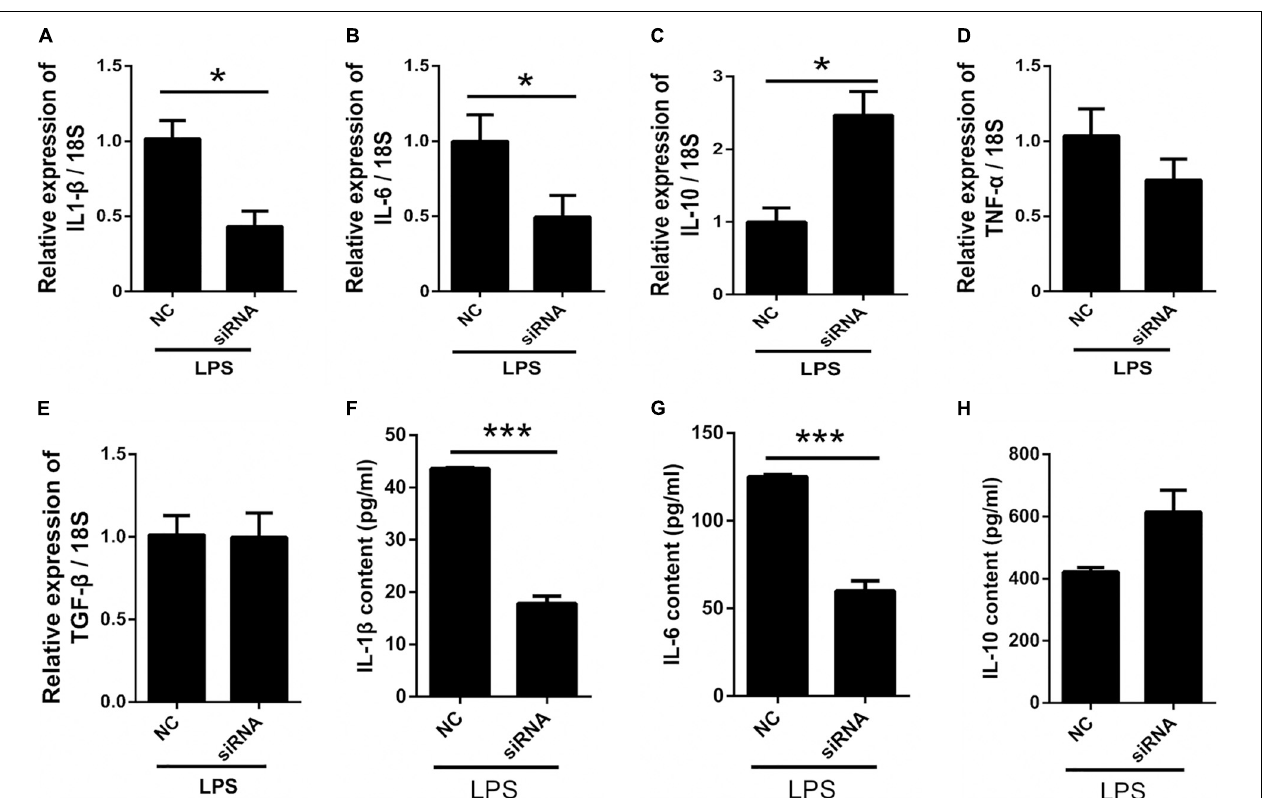
FIGURE 6 | Silencing Panx 1 inhibits LPS-induced inflammatory cytokine expression in primary cultured astrocytes. (A–E) The effect of Panx 1 downregulation on LPS-induced inflammatory cytokine mRNA expression, including IL-1 β , IL-6, TNF- α , TGF- β , and IL-10 in primary cultured astrocytes by qPCR assay. The data were normalized to GAPDH or 18S mRNA levels. (F–H) Evoked expression (content) of IL-1 β , IL-6, and IL-10 in astrocytes following with different stimulation, n = 3. All data are mean ± SEM. Statistical comparison for were performed using Student’s t -test. * p < 0.05, *** p < 0.001 compared with negative control siRNA